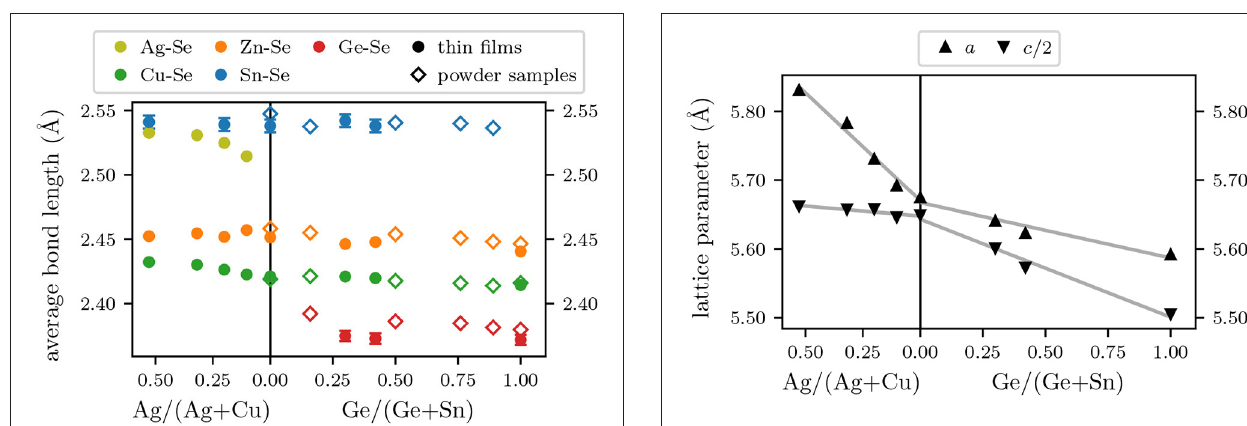
FIGURE 2 | Element specific average bond lengths between cations and Se for all thin film samples (solid symbols) and powder sample values from Ritter et al. (2020) (open symbols) as a function of Ag/(Ag+Cu) (left) or Ge/(Sn+Ge) (right) . In most cases, the error bars are about the size of the symbols or smaller and are therefore not plotted.